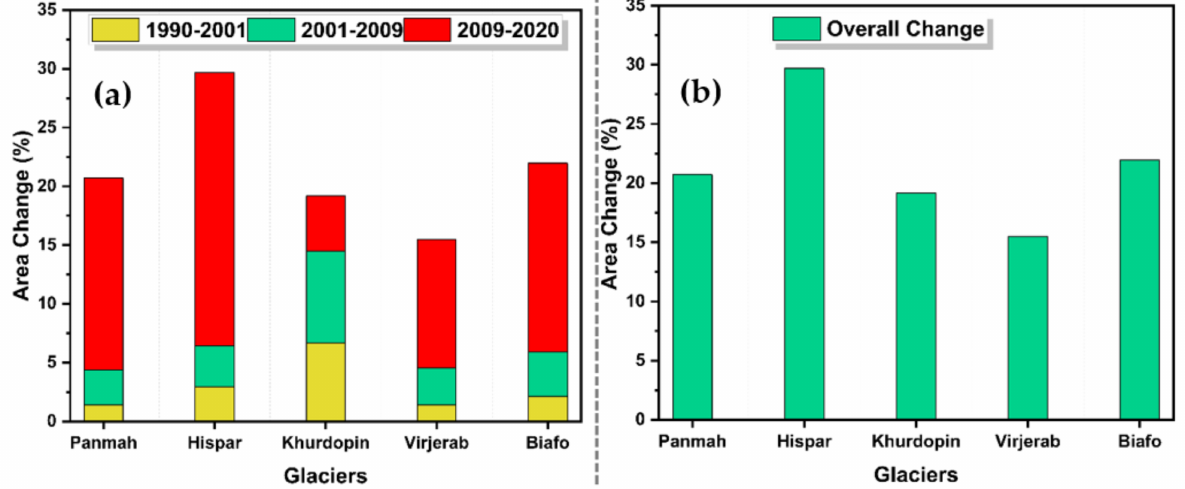
Figure 6. ( a ) Glacier area change for the periods from 1990–2001, 2001–2009, and 2009–2020. ( b ) Over- all change from